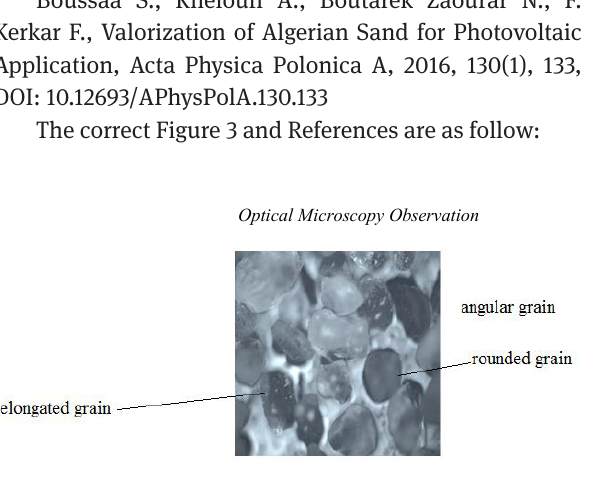
Figure 3: Micrograph of Biskra Dune Sand [23].